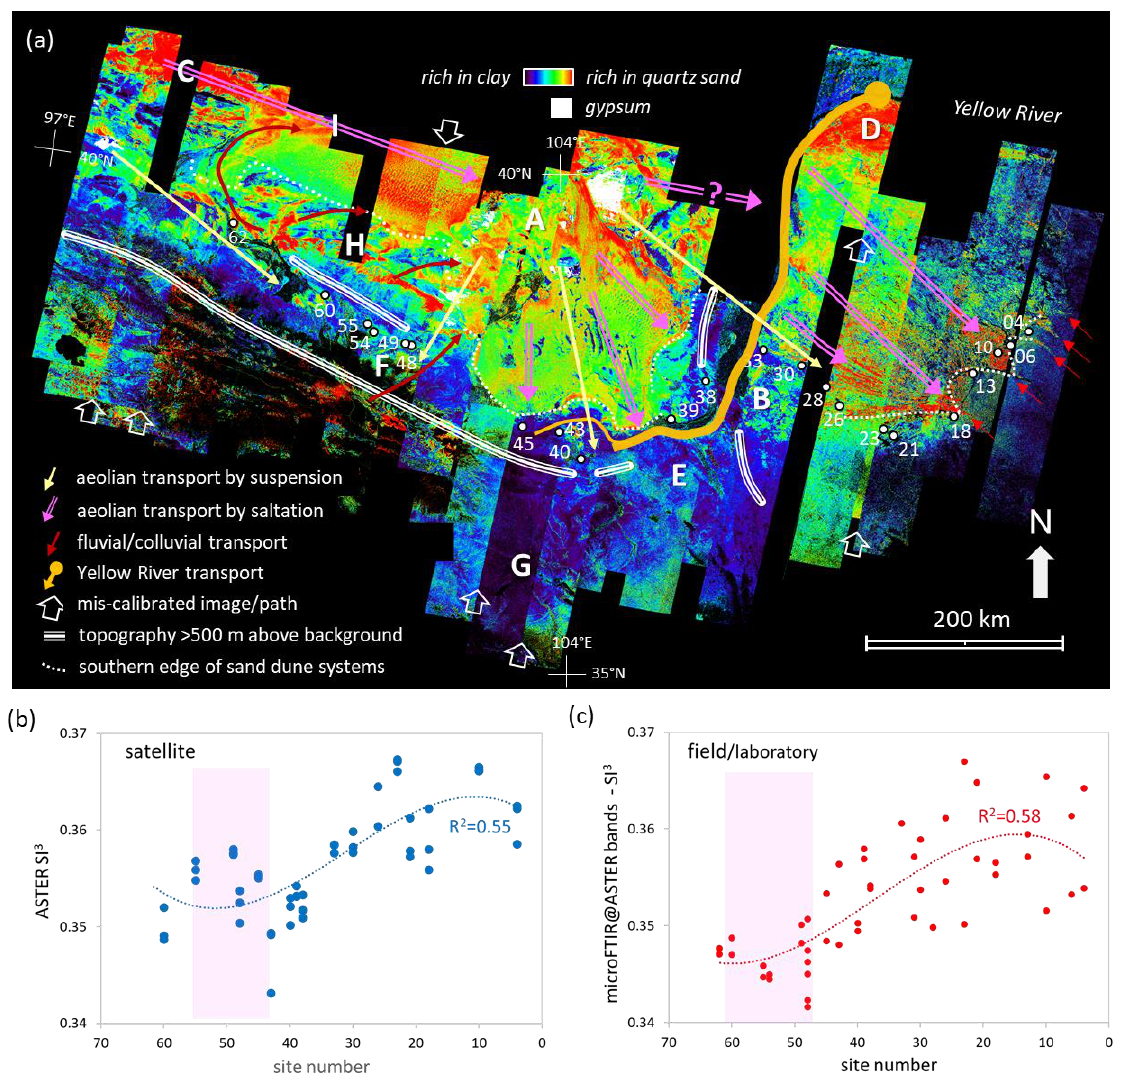
Figure 4. ( a ) ASTER SI 3 base-map depicting the proportion of quartz sand (warm colors) to clay (cool colors) material overlain with a threshold mask of the ASTER Gypsum Index (white). ( b ) Scattergram of the west-to-east spatial trend of satellite ASTER SI 3 responses collected from three (north, south, and centered over the wall) ROIs (~50 pixels each) of the field sites. ( c ) Scattergram of the west-to-east spatial trend of field SI 3 responses of wall samples only. A magenta box highlights the well-preserved “Shandan” wall section.